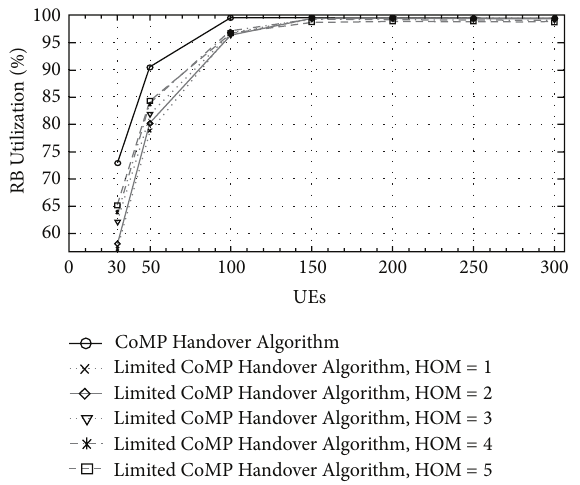
Figure7:RBUtilizationofCoMPHandoverAlgorithmandLimited CoMP Handover Algorithm in LTE-A.